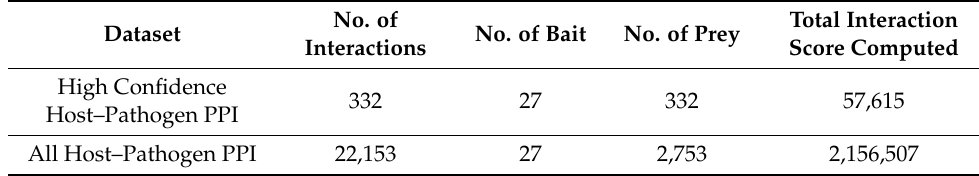
Table 5. Overall statistics for interaction affinity score of High confidence Human–nCov dataset and all Human–nCov Dataset proposed by Gordon et al. computed by our proposed model.